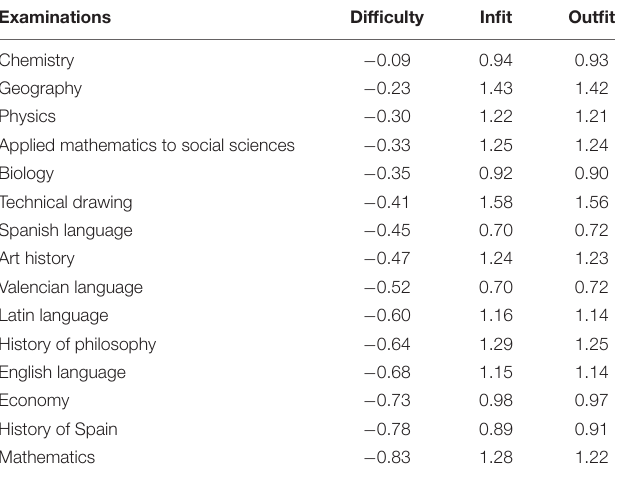
TABLE 2 | Difficulty parameters and fit statistics of the University Entrance Examinations.